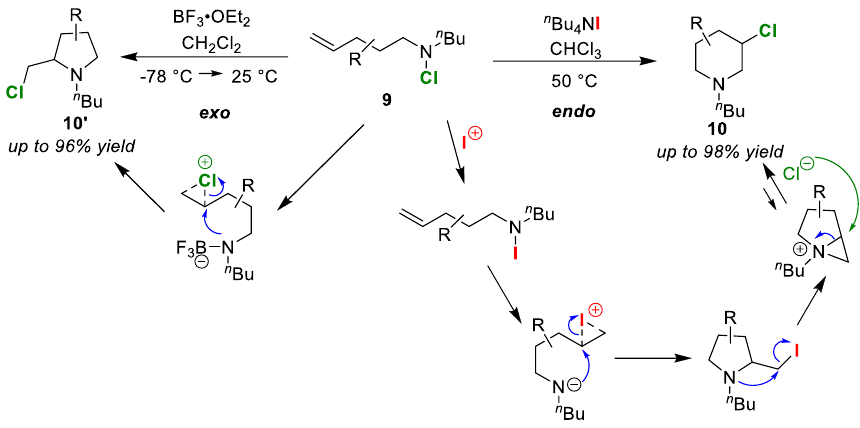
Figure 6. Endo / exo selective chloro-amino-cyclization reactions of olefinic N -chloro-amines 9 . Molecules 2020 , 25 , x FOR PEER REVIEW